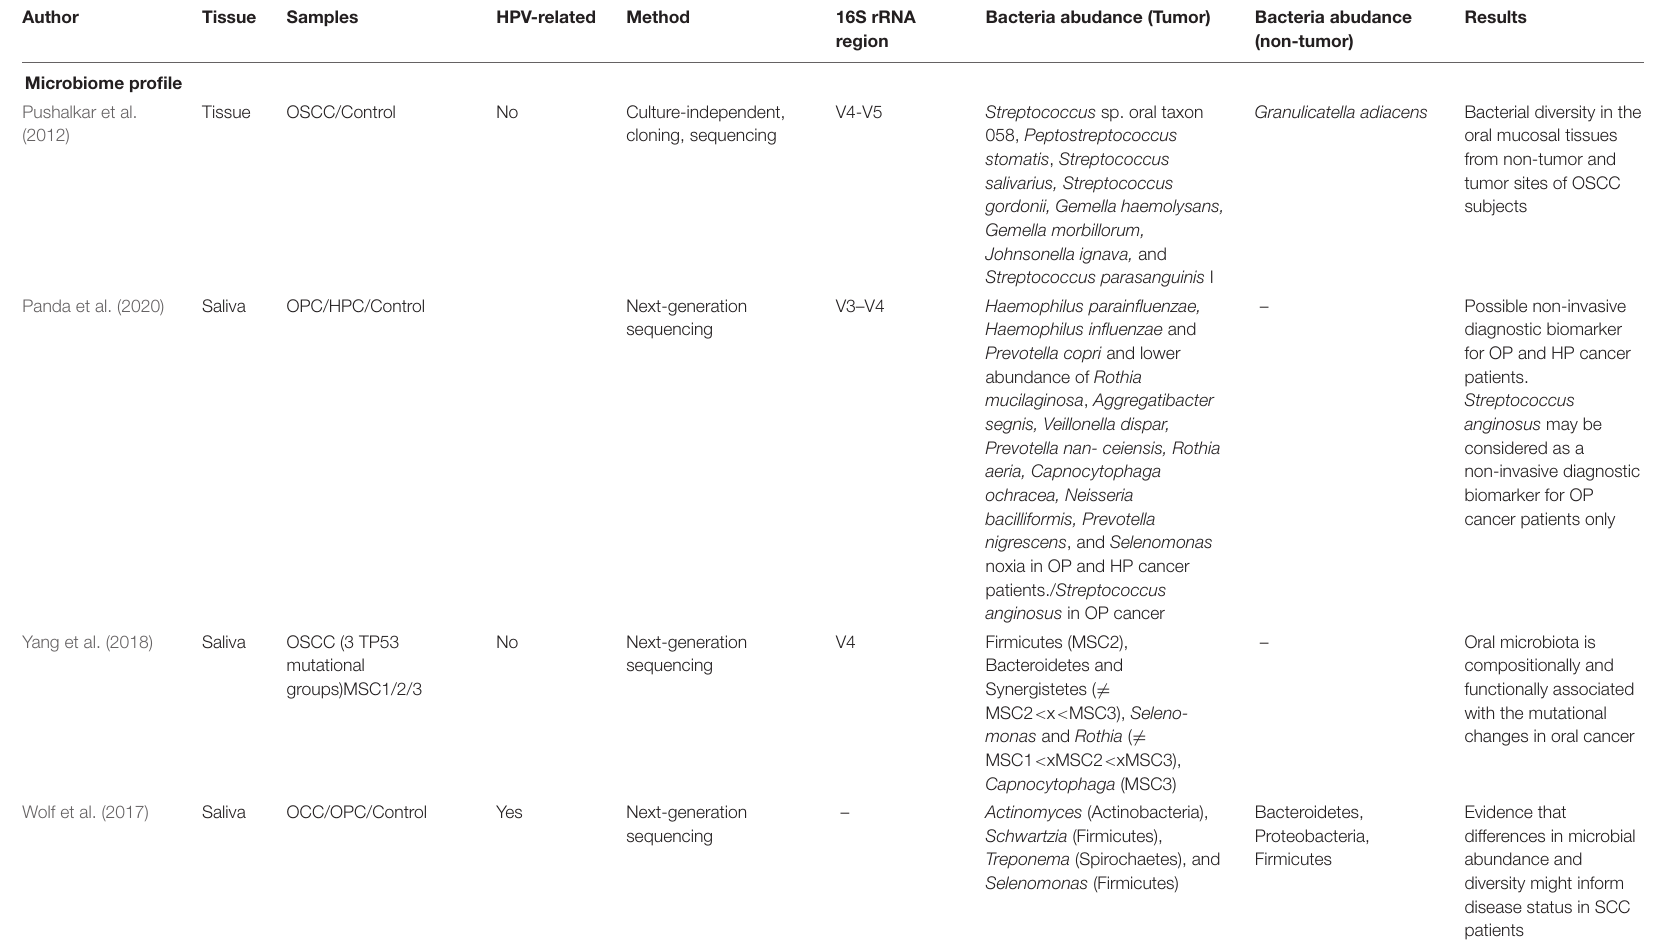
TABLE 2 | Bacteria abundance in